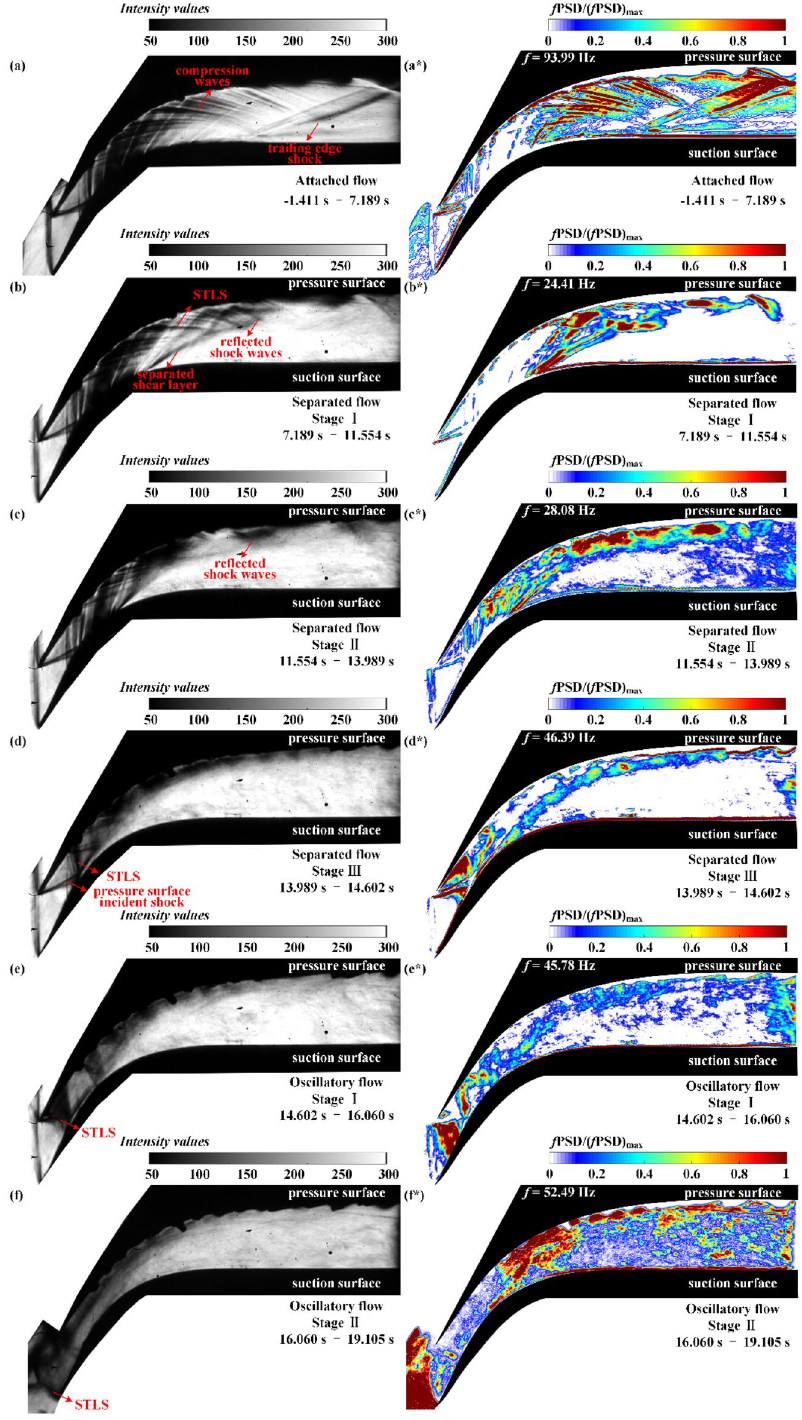
Figure 11. Schlieren images of the flow field during ( a ) attached flow, ( b ) stage I of separated flow, ( c ) stage II of separated flow, ( d ) stage III of separated flow, ( e ) stage I of oscillatory flow, and (f) stage II of oscillatory flow. The f PSD contours of flow field during ( a* ) attached flow, ( b* ) stage I of separated flow, ( c* ) stage II of separated flow, ( d* ) stage III of separated flow, ( e* ) stage I of oscillatory flow, and ( f* ) stage II of oscillatory flow at the corresponding dominant